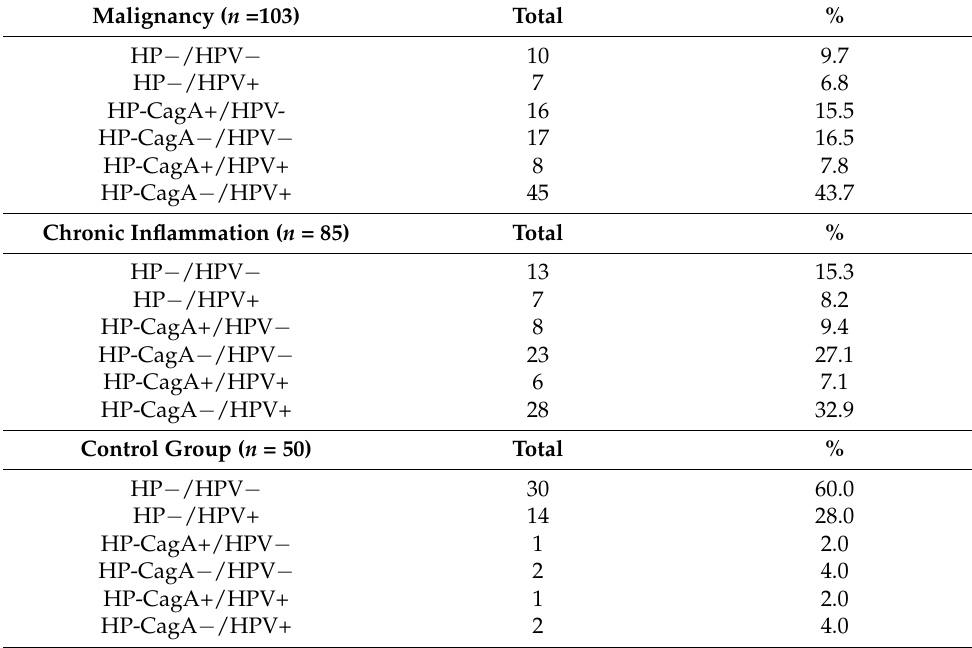
Table 4. Samples with different co-infection combinations.